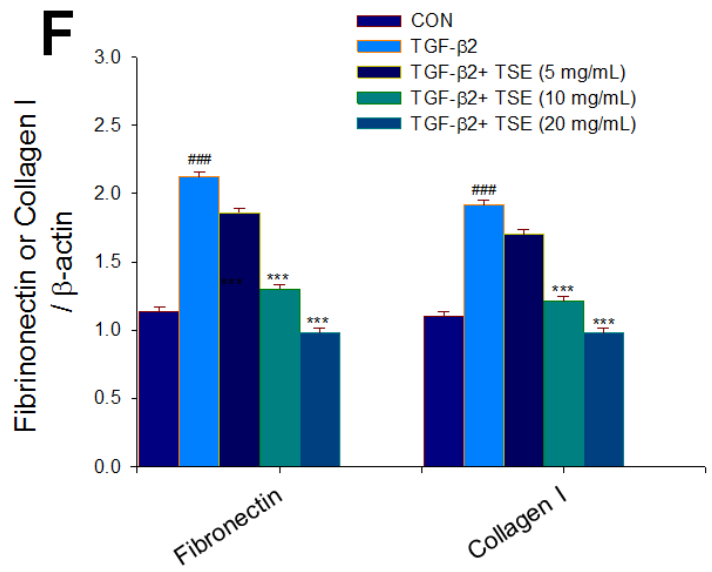
Figure 4. Effects of TSE on the mRNA or protein expression levels of TGF β 2, SMAD3, SMAD4, fibronectin, or collagen I in TGF β 2-induced SRA01/04 cells. ( A ) Representative image and ( B ) quantification of the ratio of target gene to β -actin mRNA levels. The RT-PCR amplification was performed on PCR Detection System. The relative gene expression is assayed with agarose gel electrophoresis. Protein was separated by 12% SDS-PAGE detected by Western blot: ( C , E ) representative image, and ( D , F ) quantification of the target gene to β -actin. ### p < 0.001 in comparison to control cells; * p < 0.05, ** p < 0.01 or *** p < 0.001 in comparison to TGF- β 2-induced control cells. Values are the mean ± SE (n = 3).